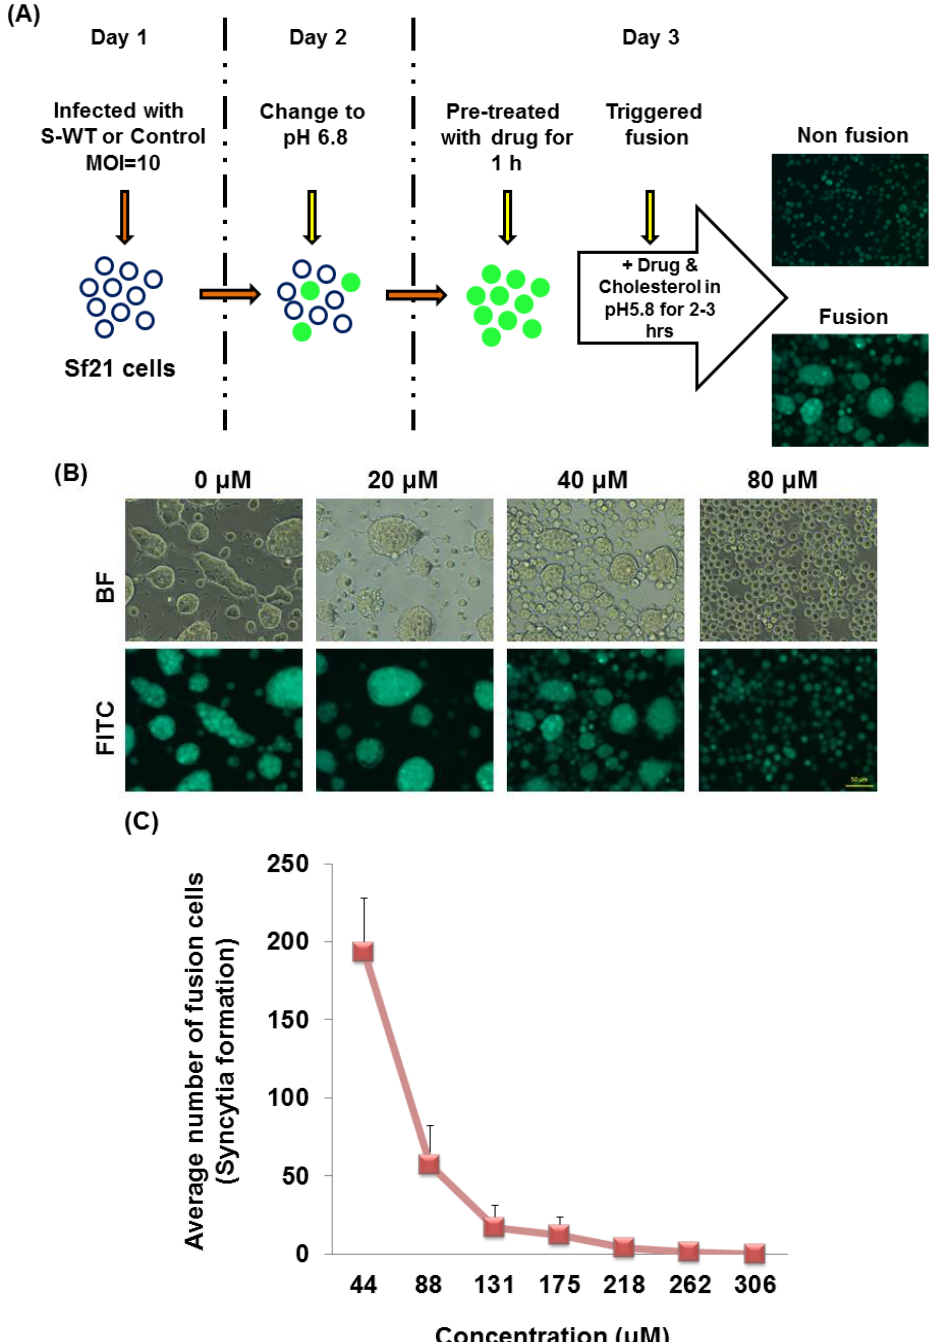
Figure 4. Establishment and analysis of recombinant baculovirus-mediated insect cell fusion inhibition assay. ( A ) Schematic representation of the CHIKV 26S-mediated insect cell fusion inhibition assay. ( B ) Baculovirus vector vAc-CHIKV26S-Rhir-EGFP infected to Sf21 cells at pH 5.8. The effect of ursolic acid on CHIKV 26S-mediated Sf21 cell fusion in 0, 20, 40, 80 µM concentrations were examined under a fluorescence microscope with a FITC channel (lower panel) and bright field (upper panel). Pictures from upper and lower panels were taken in the same field. Sf21 cells were infected with recombinant baculovirus of vAc-CHIKV26S-Rhir-EGFP, at multiplicity of infection MOI of 10. The bar represents 50 µm. ( C ) Dose – response curve of ursolic acid on CHIKV 26S mediated Sf21 cell fusion. Dose dependent curve shows anti-CHIKV effects of Ursolic acid. The fusion was calculated by counting the number of each cell – cell aggregation contain at least three nuclei as syncytia formations and normalizing the value with respect to that of the virus control group (mock), all the data were replicated 3 times.